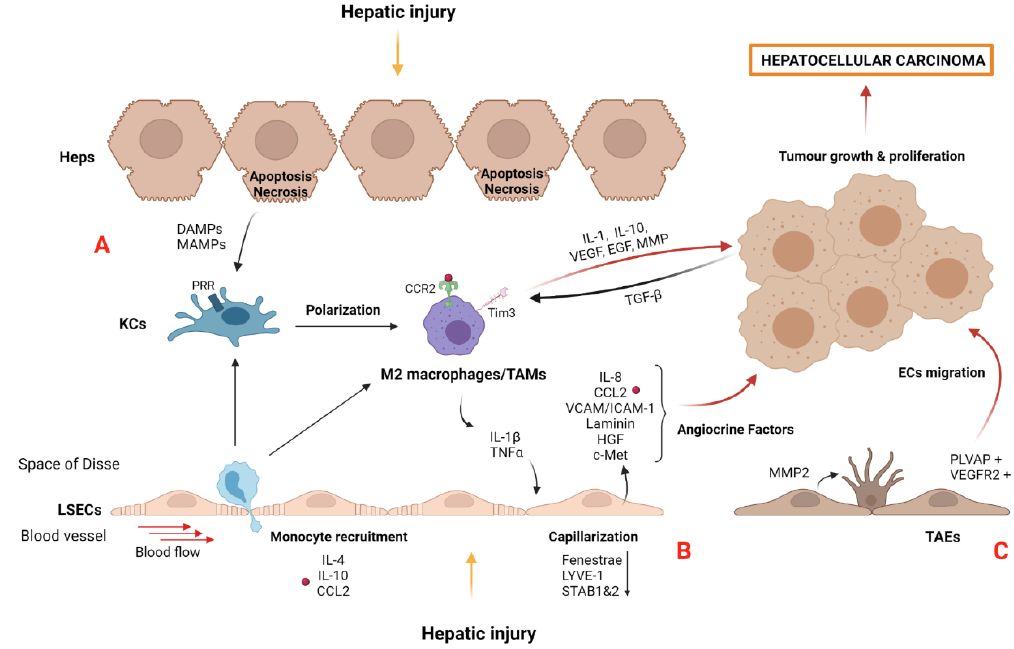
Figure 4. Liver damage activates and dysregulates liver macrophages and LSECs’ role in